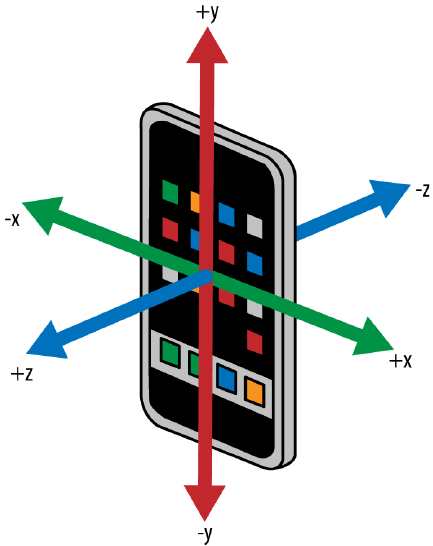
Figure 4. Camera coordinate